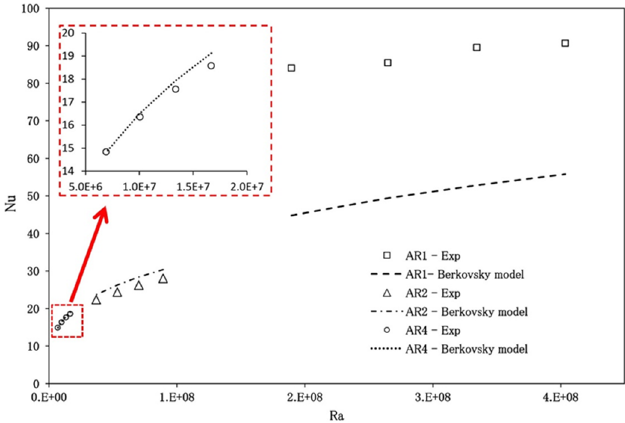
Figure 3. Impact of different aspect ratios on cavities [39].